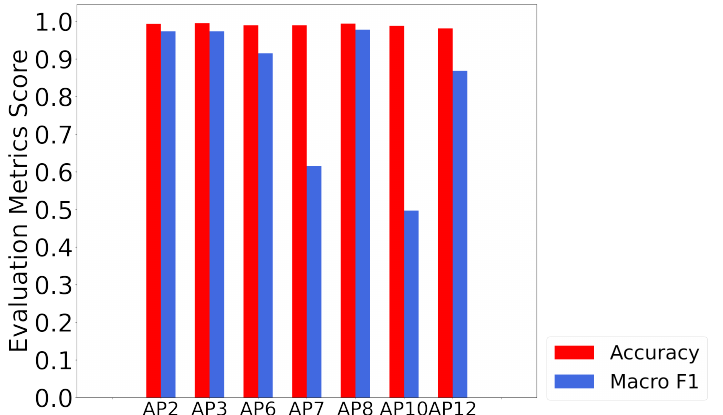
Figure 21. The performance of the individual AP identification. APs which do not have LOS path to any RP are not included. Please note that only 8 and 4 RPs have LOS path to AP7 and AP10, respectively. MSS selected features achieve more than 0.5 F1 score performance even in APs with insufficient